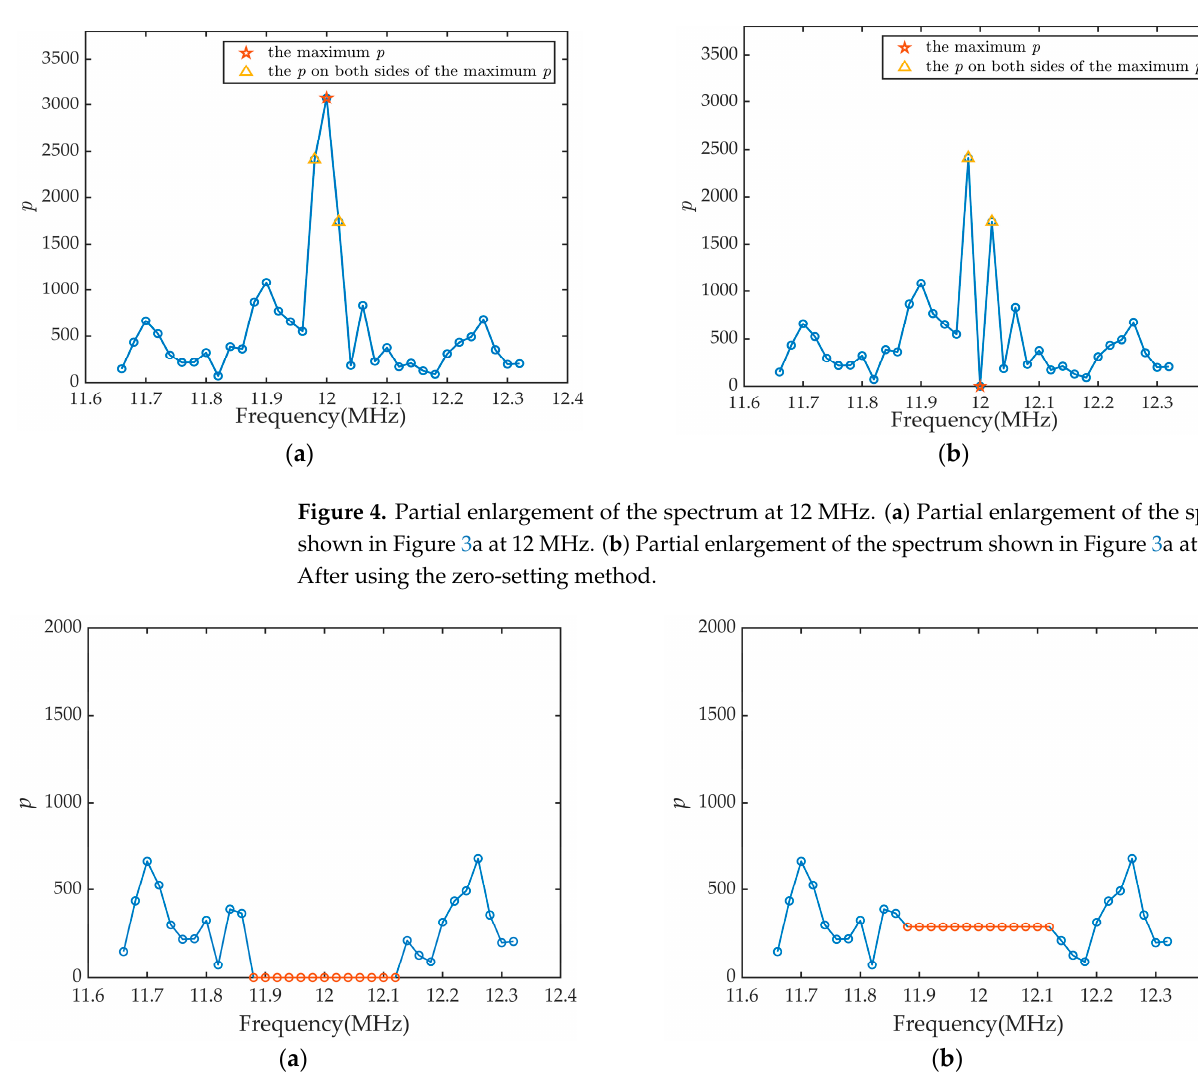
Figure 6. Flow chart of the CSML algorithm. The specific steps are described as follows: Step 1: Split the received signal (